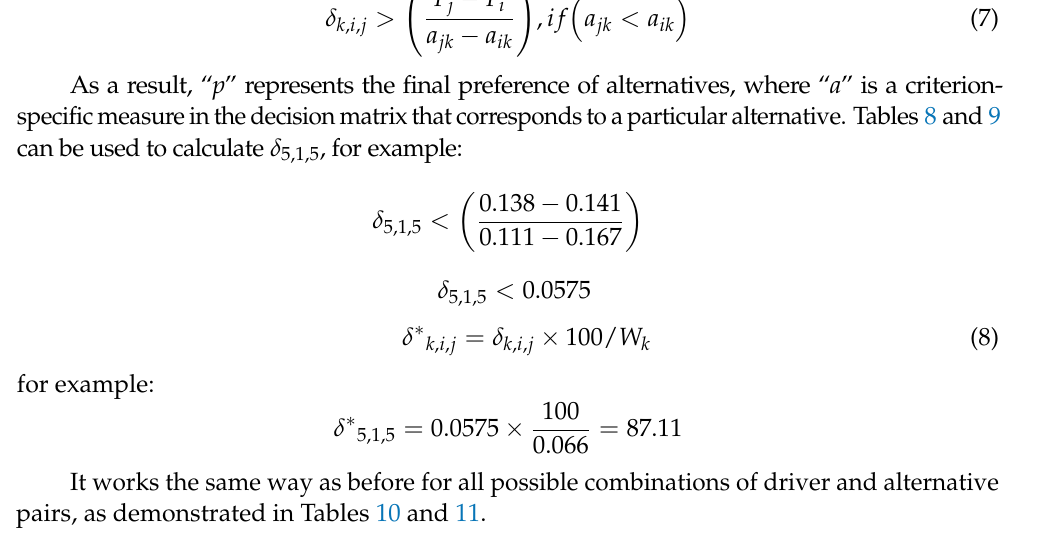
Table 10. Absolute changes ( δ k,i,j ) in driver